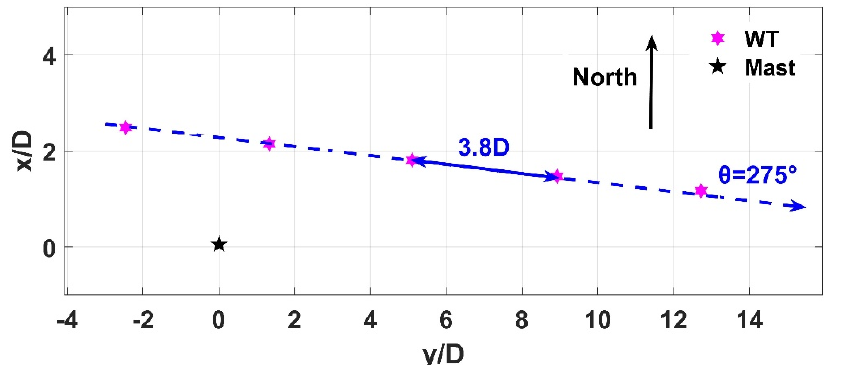
Figure 9. Layout of the EWTW onshore wind farm.